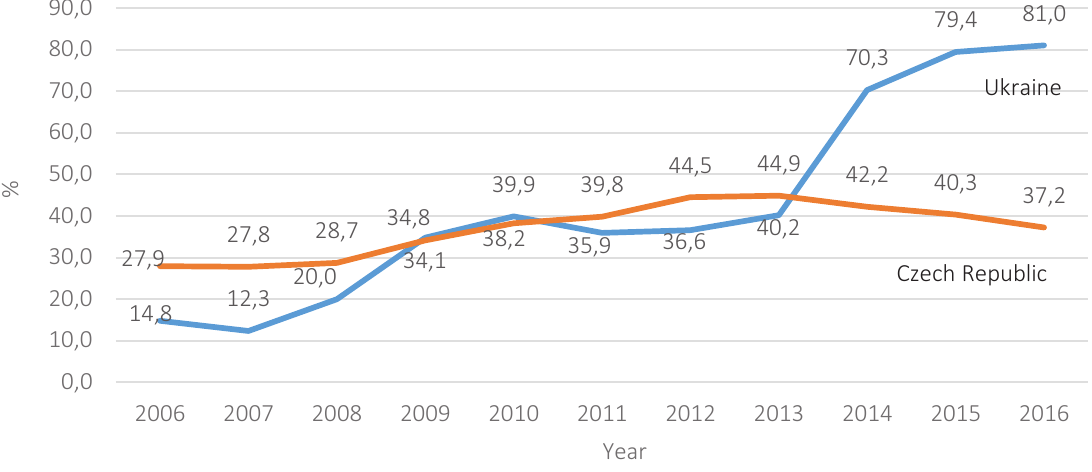
Figure 5. The ratio of government debt in Ukraine and the Czech Republic, % of GDP, 2006–2016